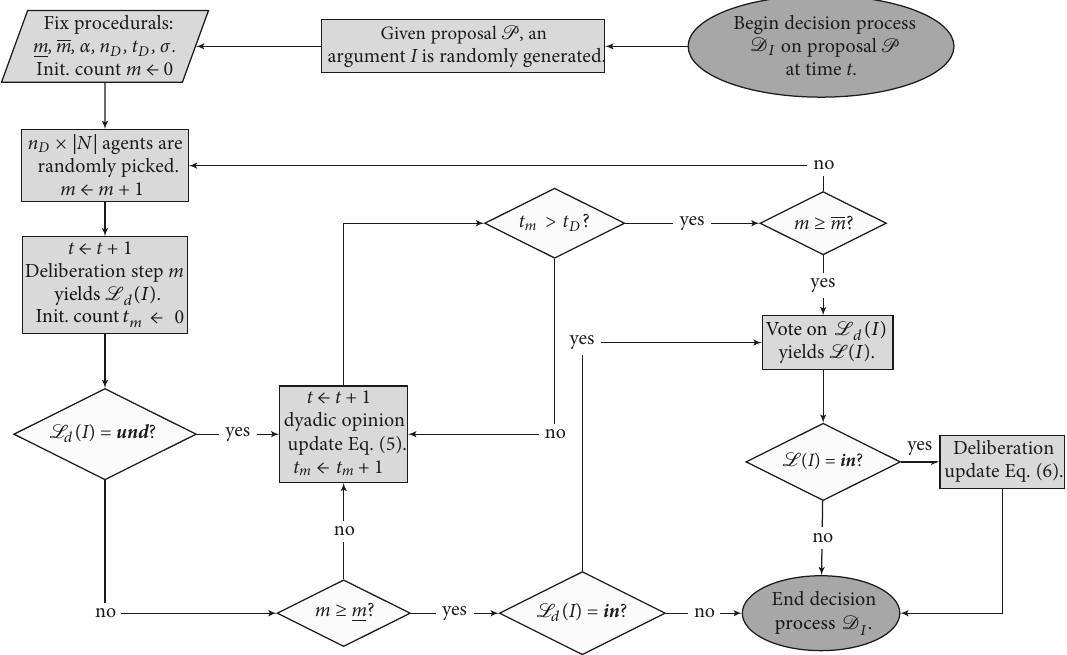
Figure 5: Process chart for a decision process D 𝐼 on a proposal P . 𝑡 corresponds to time, and 𝑚 ( 𝑡 𝑚 ) corresponds to the number of debate (non-debate) steps that have taken place in the deliberation process (in between two debate steps) over time for the mixed discussion model. We use L 𝑎𝑏(𝐼) and L (𝐼) interchangeably in the figure for